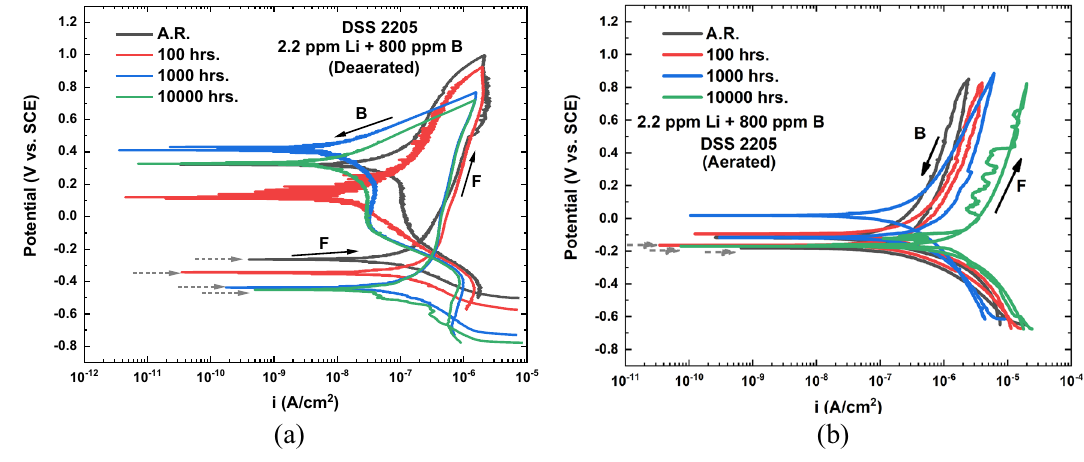
Fig. 6 Corrosion potential plots for DSS 2205 with increasing thermal aging time in a deaerated and b aerated base electrolyte (2.2 ppm Li, 800 ppm B), showing a decrease in E values with increasing aging duration. ( F : forward loop; B : backward corr